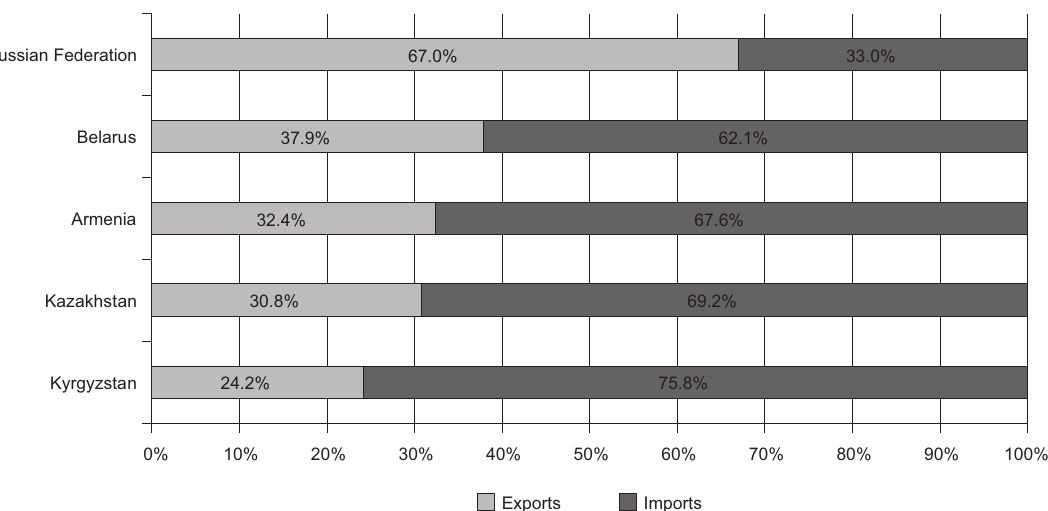
Fig. 3. Structure of mutual merchandise trade by the EAEU Member states in 2018. Source: own study based on the Eurasian Economic commission (n.d.).